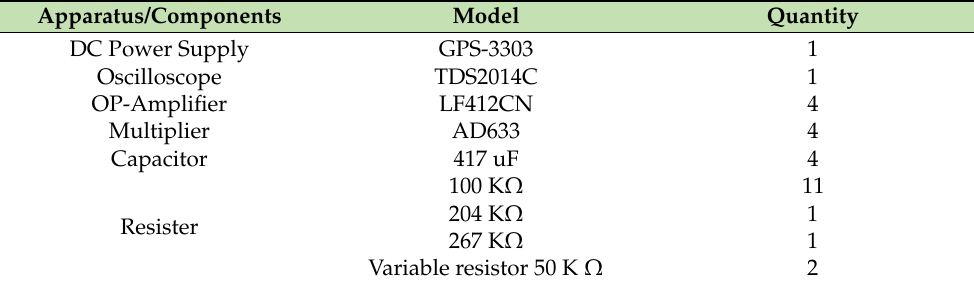
Table 1. List of apparatus and components in the circuit experiment.